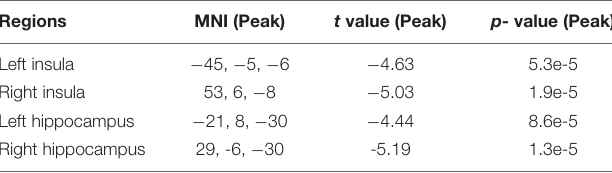
TABLE 2 | Reduce volume of gray matter in patients with KOA pain.